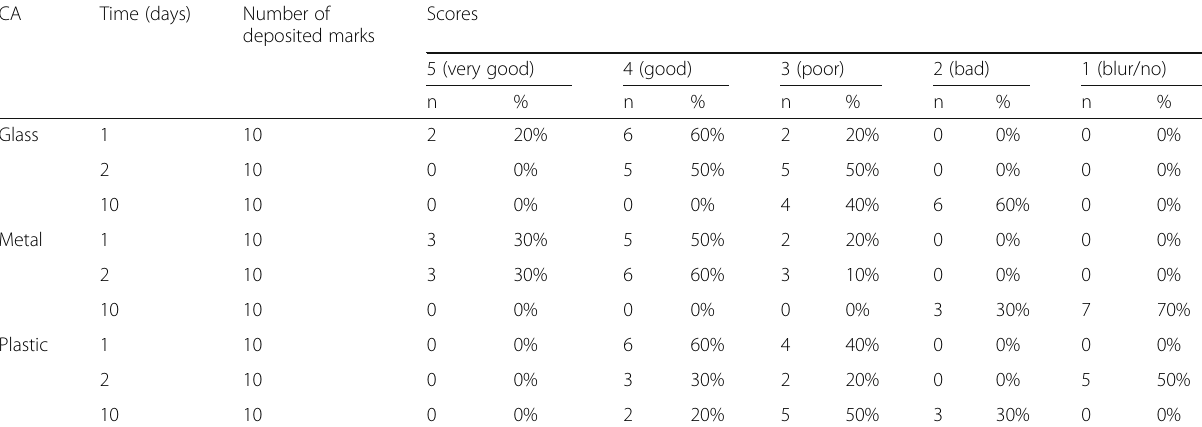
Table 3 Fingerprints development scores using CA technique on glass, metal and plastic surfaces submerged in sea water at 1, 2 and 10days ’ intervals according to fingerprints quality assessment scale CA